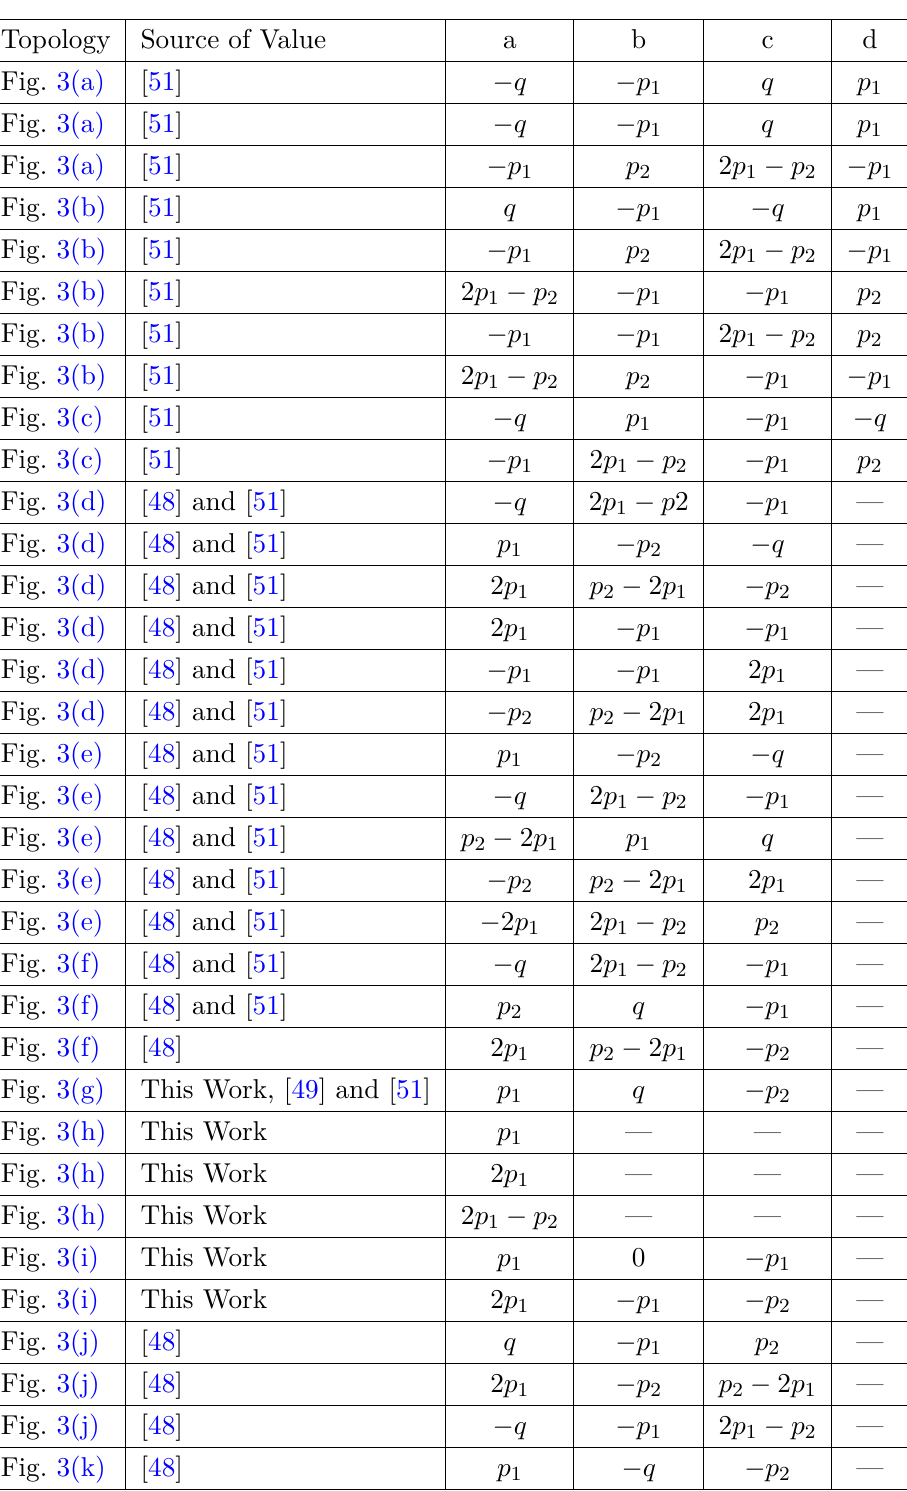
Table 2. The master integrals for this work in the SMOM kinematics. For master topologies, see figure